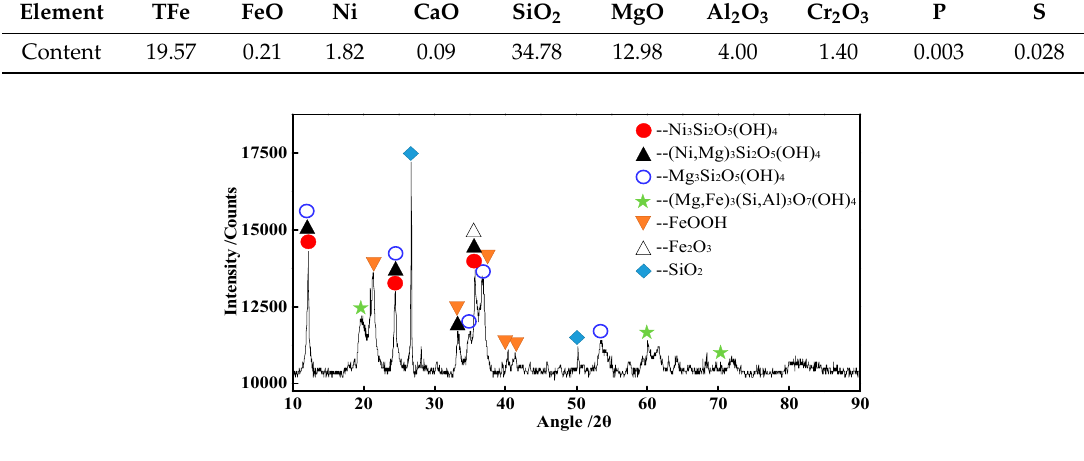
Figure 1. X-Ray Diffraction (XRD) analysis of laterite nickel ore. Table 2. Industrial composition of the coal (wt